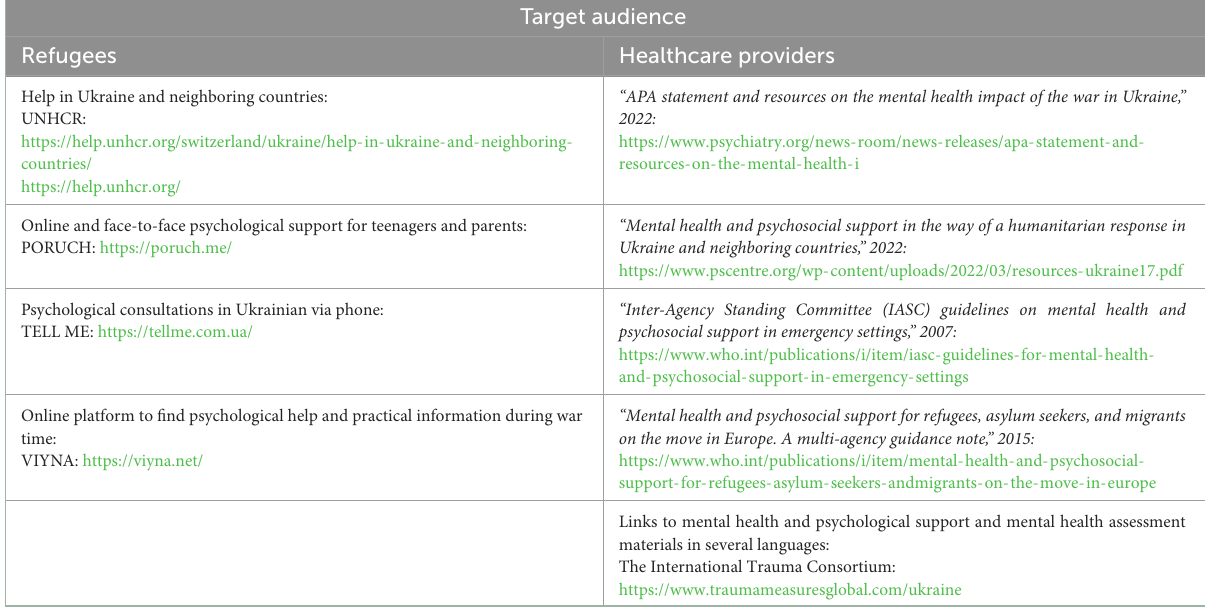
TABLE 1 Examples of resources available to refugees and healthcare professionals to provide mental health support